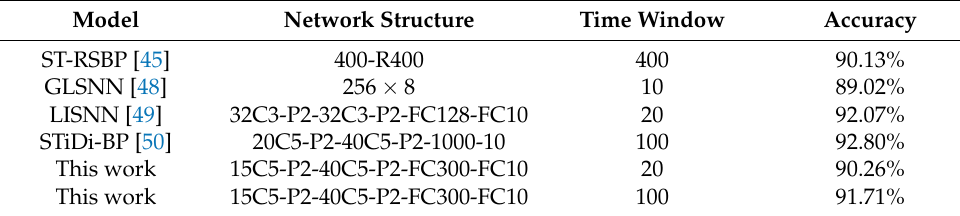
Table 8. Comparison with other SNNs model over Fashion-MNIST